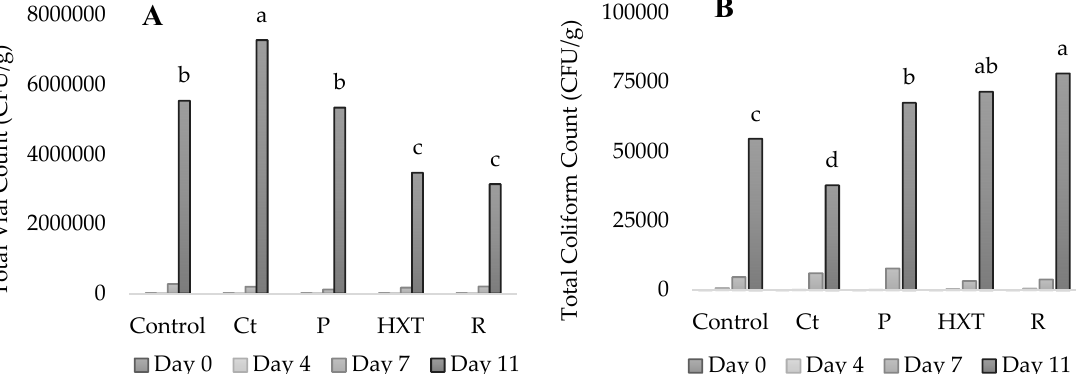
Figure 3. Evolution of microbiological growth during shelf-life study of fish patties. Total vial count (TVC; A ). Total coliform count (TCC; B ). Control (C); 200 ppm acerola + 200 ppm citric extract (Ct); 200 ppm acerola + 200 ppm hydroxytyrosol extract (HXT); 200 ppm acerola + 200 ppm pomegranate extract (P); 200 ppm acerola + 200 ppm rosemary extract (R). Different letters (a, b, c, d) in the same column indicate significant differences between samples ( p < 0.05).